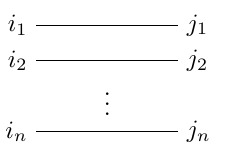
IJ represents a con(cid:12)guration of n open strings with Chan-Paton indices j i